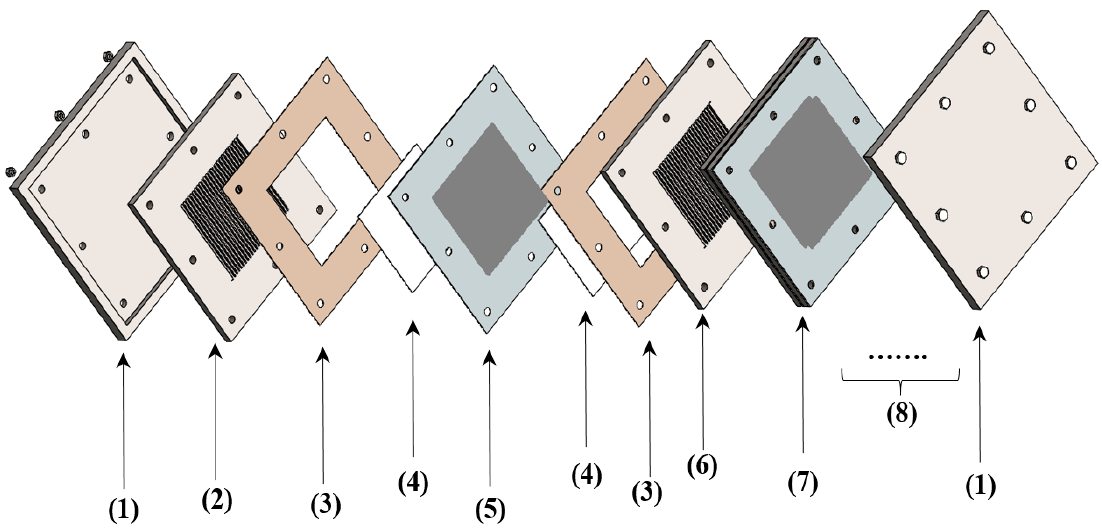
Figure 1. An exploded view of a PEM fuel cell stack: (1) clamping plates; (2) endplates; (3) gasket; (4) gas diffusion layer; (5) catalyst layer; (6) bipolar plate; and (7) stack. Metals are denser than composite or graphite, so an inherent reduction in their